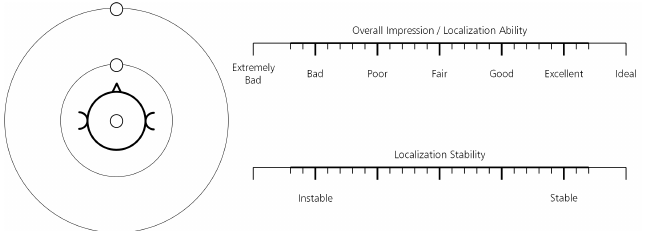
Figure 12. Rating scales for externalization, overall impression, localization ability, and stability. Scale design on the right from Jekosch-Bodden named in [42]. The designation of the upper scale with two quality features is only for this figure. In the evaluation, each feature was evaluated with its own scale.